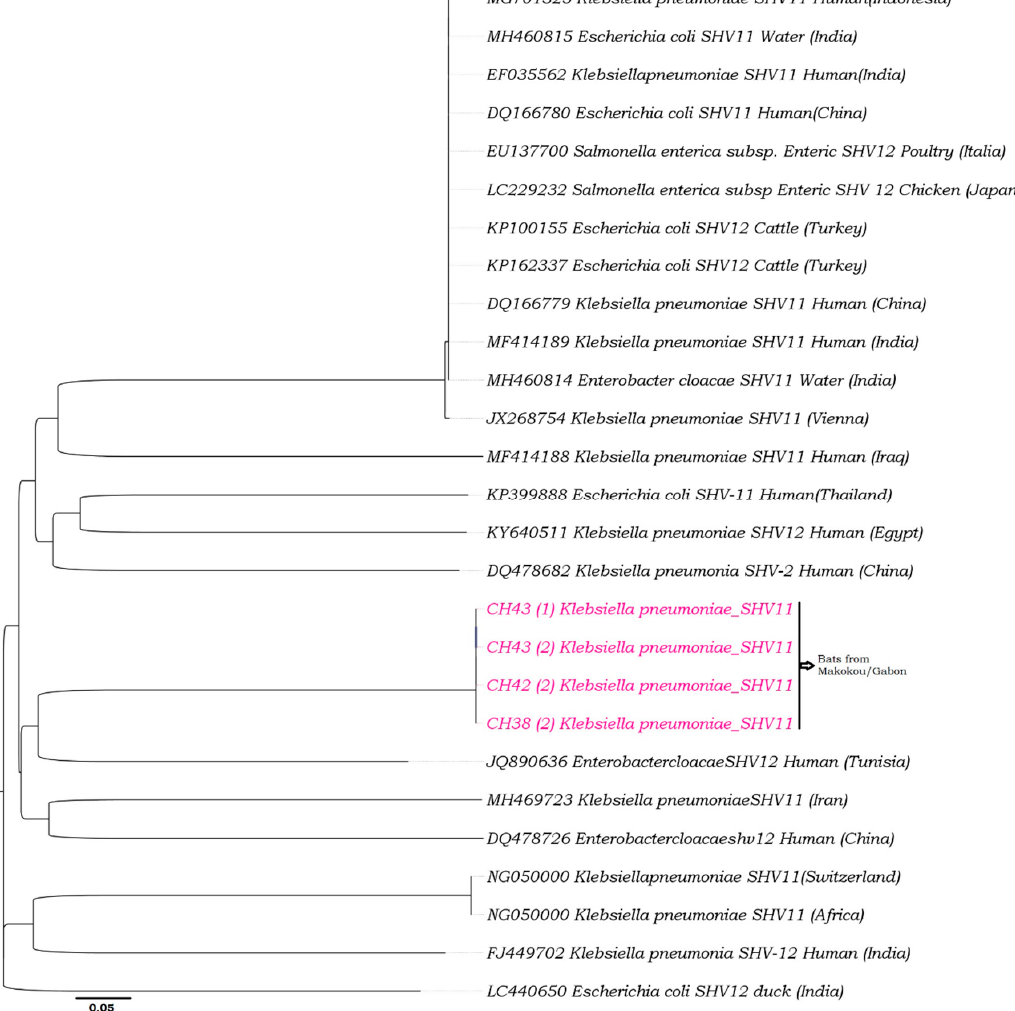
Figure 2. Phylogeny of SHV-11 from bats.